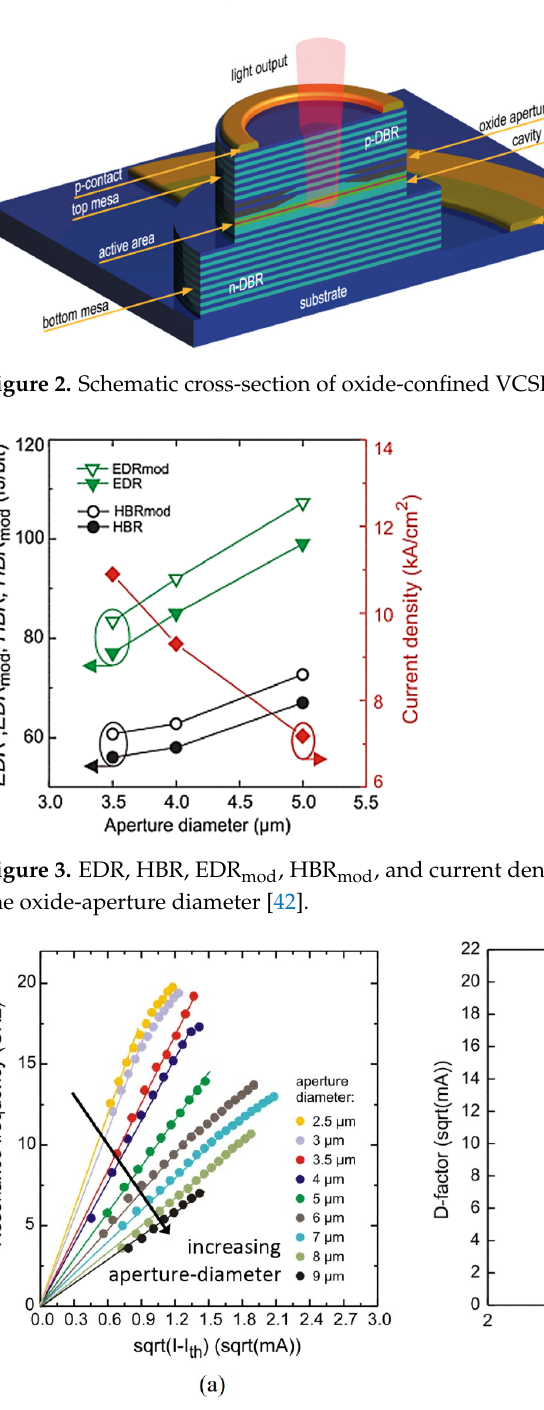
Figure 4. ( a ) Relaxation resonance frequency versus the square root of the current above the threshold current for 850 nm VCSELs with aperture diameters ranging from 2.5 to 9 μ m. The straight lines indicate the linear fits to obtain the D ‐ factors. ( b ) D ‐ factors versus the aperture diameters of 850 nm VCSELs [42]. 3.2. 980 nm and 1060 nm VCSELs High ‐ speed VCSELs with wavelengths from 980 to 1100 nm have attracted a lot of attention recently, although they are not yet included in the standards of IEEE [44]. Compared with 850 nm high ‐ speed VCSELs, devices emitting at longer wavelengths benefit from lower chromatic dispersion and lower transmission loss in MMF, and a larger temperature insensitivity of the quantum efficiency, due to reduced carrier spill ‐ out of the well. Again, strained InGaAs QWs (or QDs) can be used to create emissions from 980 to 1100 nm. These QWs show a larger differential gain and lower transparency carrier density, allowing a larger D factor, and in turn, a larger modulation bandwidth. Work on high bit rate NRZ ‐ OOK data transmission in MMF links was carried out for 980 to 1100 nm VCSELs [16,32–35,45,46]. At 980 nm, the TU Berlin group demonstrated a 46 Gb/s NRZ ‐ OOK data transmission at 85 °C [33]. By optimizing the photon lifetime of 980 nm VCSELs, Larisch et al. increased the data rate to 50 + Gb/s at 85 °C [16], a number limited then by the measurement set ‐ up. Li et al., from Bimberg’s group, realized error ‐ free data transmission at 38 Gb/s at 85 °C, with a record low HBR of 177 fJ/bit by using 980 nm VCSELs [32]. The active region of the VCSEL was formed by five 4.2 nm ‐ thick compressively strained In 0.21 Ga 0.79 As QWs surrounded by 6 nm GaAs 0.12 P 0.88 partially strained compensating barrier layers. The